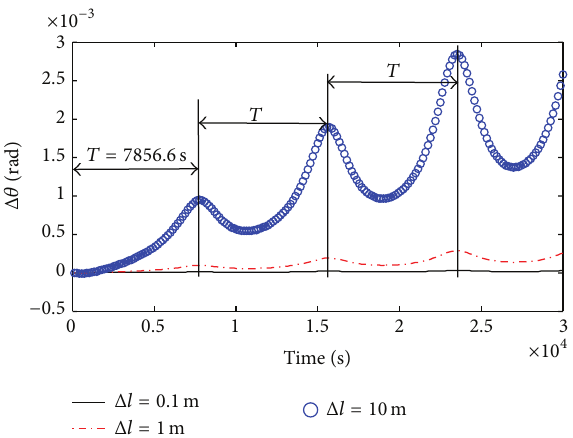
Figure 12: Time history of Δ𝜃 with different Δ𝑙 , 𝜏 = 250 kN ⋅ m.